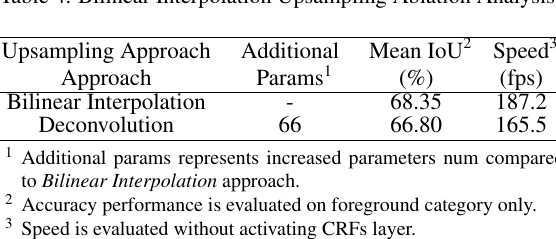
Table 4. Bilinear Interpolation Upsampling Ablation